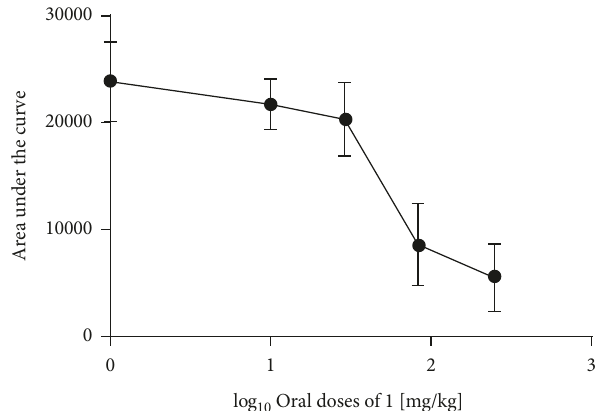
Figure 2: Dose-response curve of 23,24-dihydrocucurbitacina D (1). The area under the glucose tolerance curve as an integrated expression of glycemia. The error bars represent the standard error mean of measurements for n �